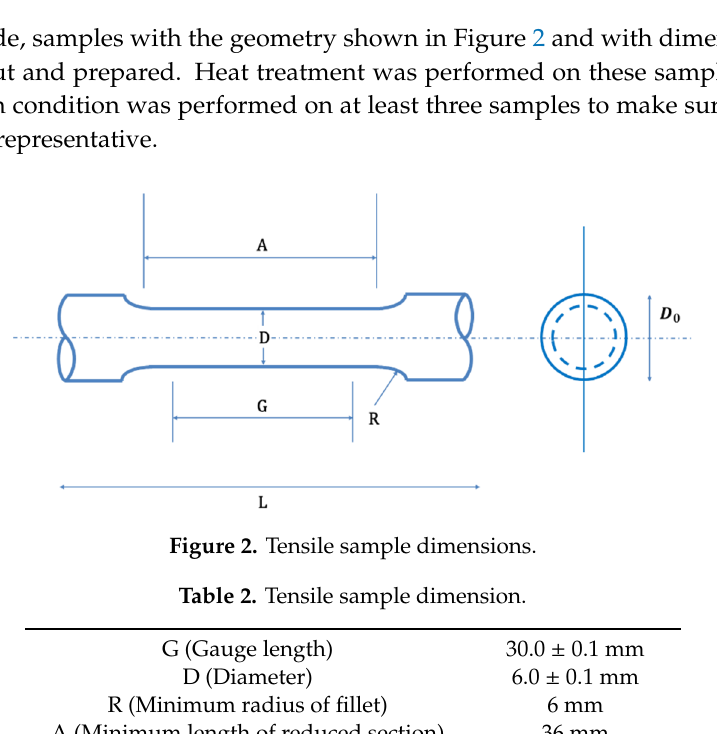
Figure 1. Sample preparation for uniaxial tensile test machine; ( a , b ) Images of specimens cut from real used rails.